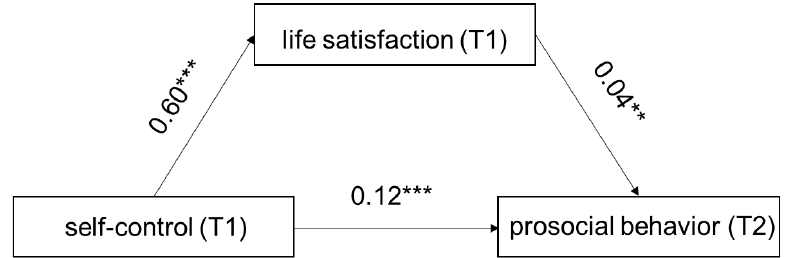
Figure 2. Model of the mediating role of life satisfaction between self-control and prosocial behavior. (T1) represents the score obtained at T1. (T2) represents the score obtained at T2. Note: ** p < 0.01, *** p < 0.001.